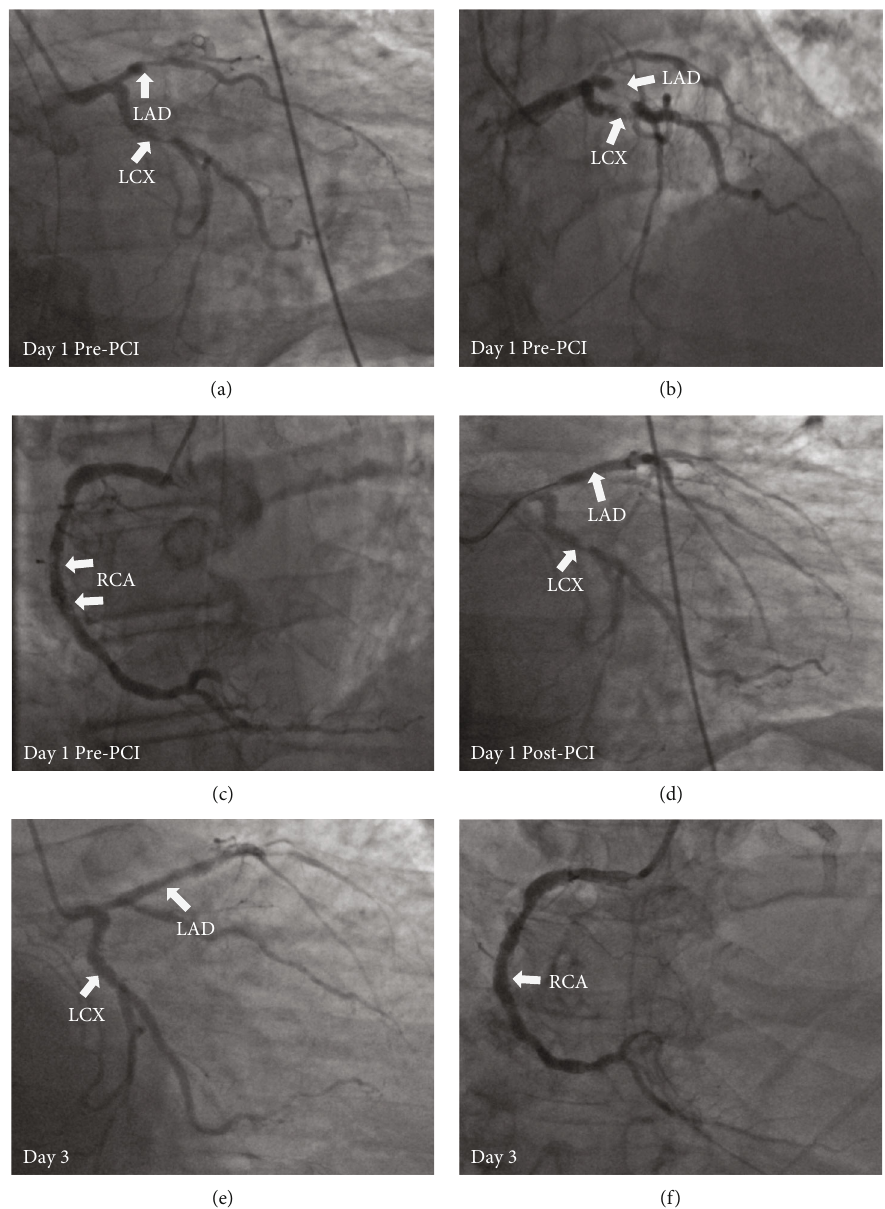
Figure 1: Coronary angiography and LAD primary PCI. Thrombotic occlusion at the site of the proximal LAD stent with TIMI 0 fl ow (A, B, arrow) and evidence of thrombus at the site of the proximal LCX stent (A, B, arrow) and the mid RCA stent (C, arrows). Following PCI and restoration of TIMI 3 fl ow in the LAD, there was evidence of remaining thrombus at the site of proximal LCX stent (D, arrow). Resolution of thrombus at the site of the proximal LCX stent (E, arrow) and the mid RCA stent (F, arrow) on day 3 of admission. LAD: left anterior descending artery; LCX: left circum fl ex artery; RCA: right coronary artery; PCI: percutaneous coronary